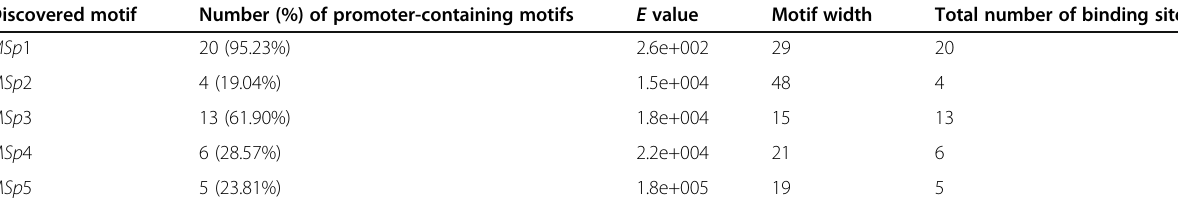
Table 4 List of discovered motifs and the number and proportion of promoter-containing motifs for S. pombe 972h- Discovered motif